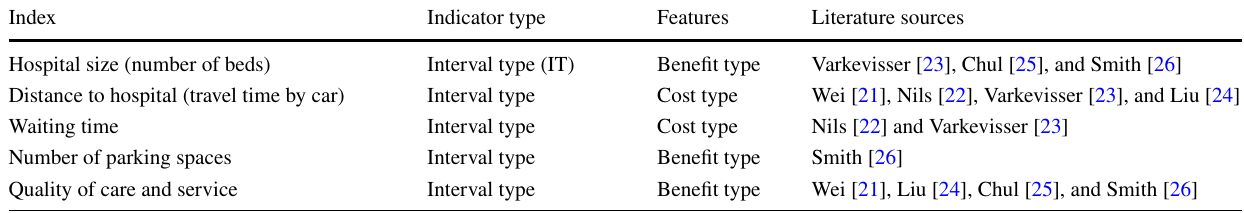
Table 2 Evaluation index set of patients for